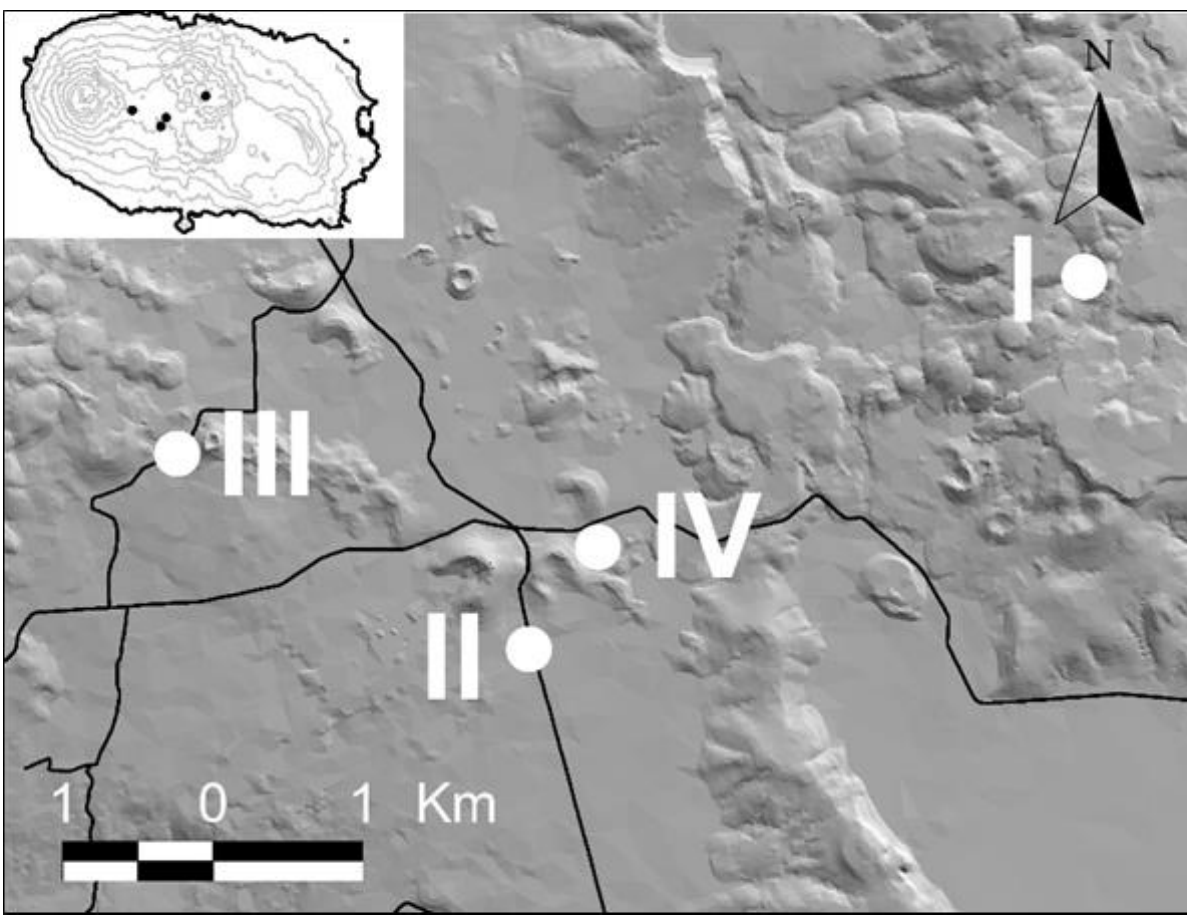
Figure 3. Locations of the four studied bogs, which all lie above 500 m a.s.l. on Terceira Island